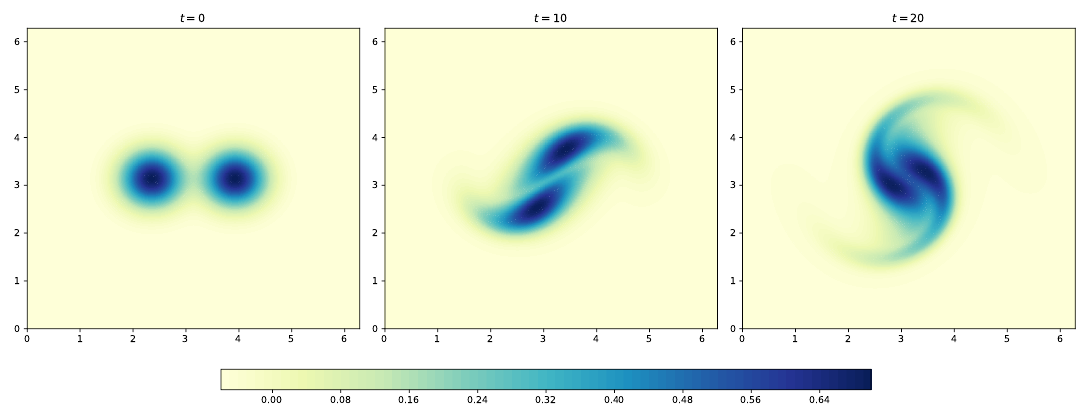
Figure 27. Evolution of the vorticity field at three time steps during the co-rotating vortex interaction. The solution is computed using hybrid Arakawa-spectral